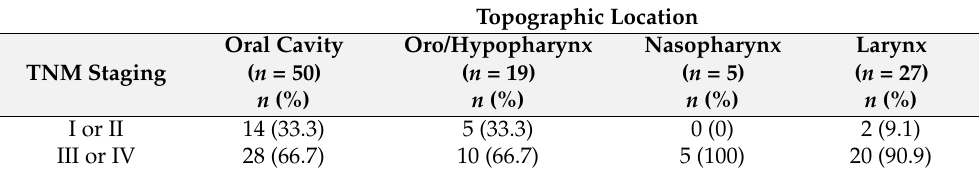
Table 3. TNM staging of head and neck cancer patients by topographic location.